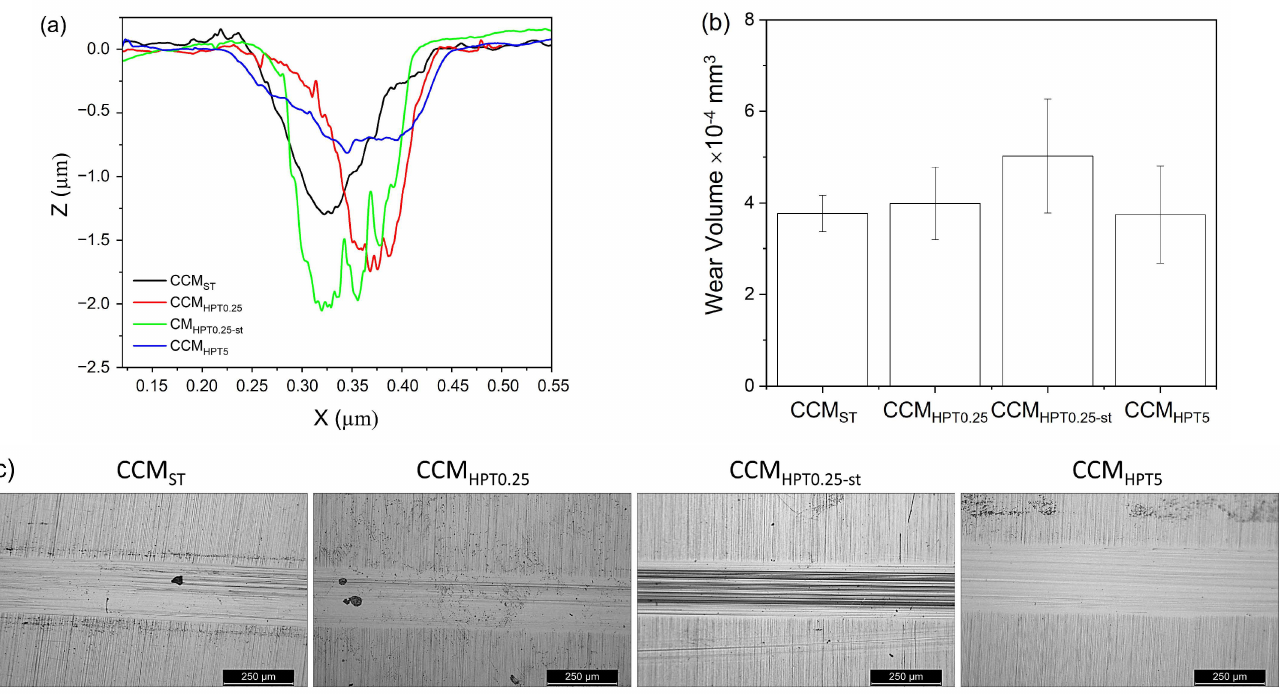
Figure 10. Analysis of the worn surfaces: ( a ) representative wear track profiles, ( b ) total wear volume loss, and ( c ) OM images of wear tracks for each